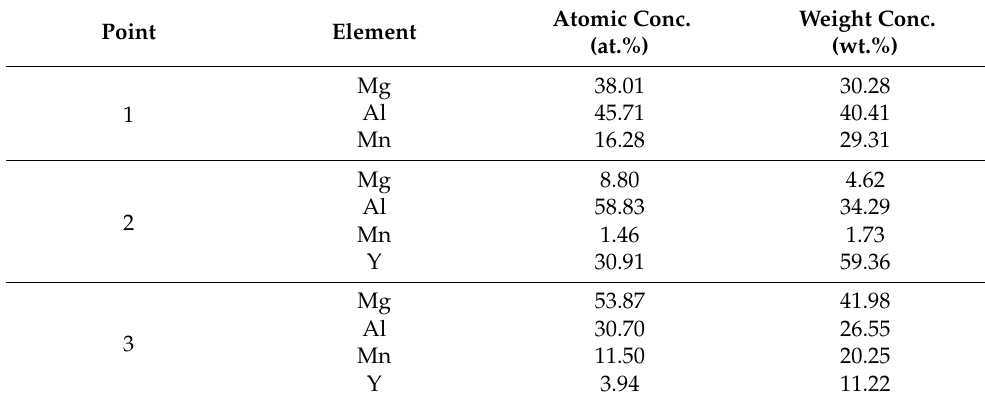
Table 2. Test components of EDS points for the AZ61 sheets with different Y